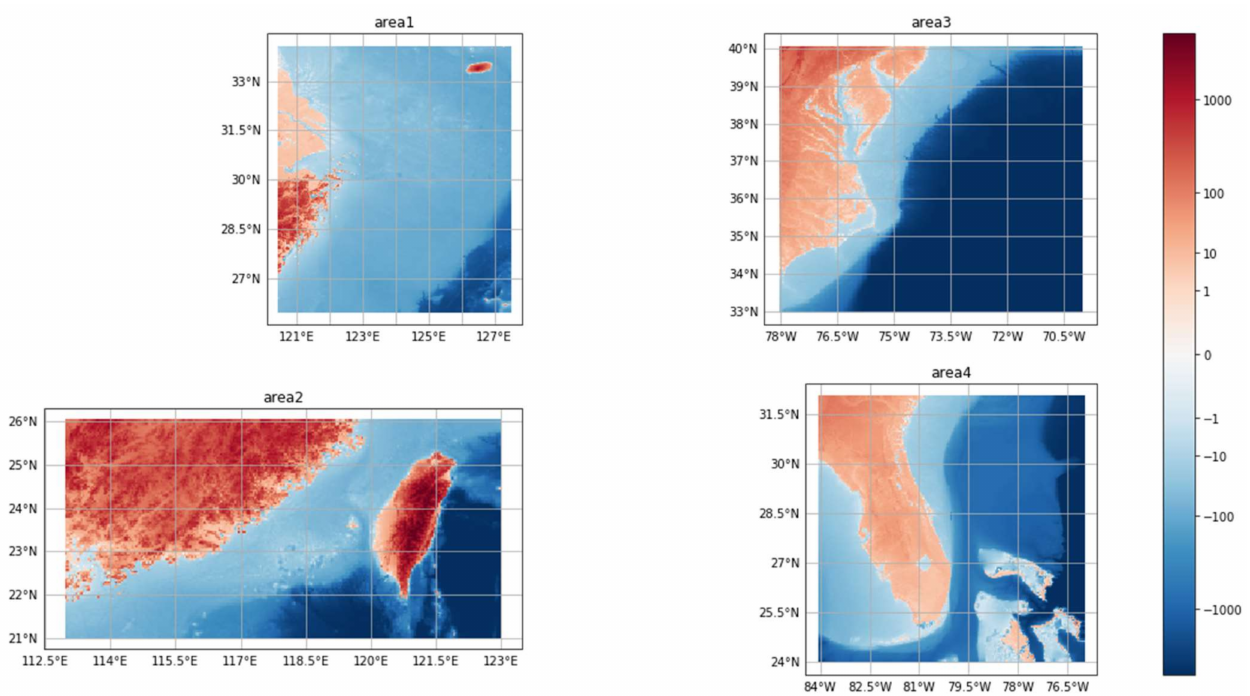
Figure 3. Seafloor or land height (above mean sea level) in meters of the four